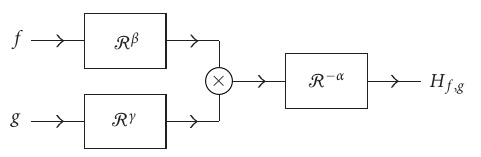
Figure 2: Schematic representation of the generalized fractional convolution